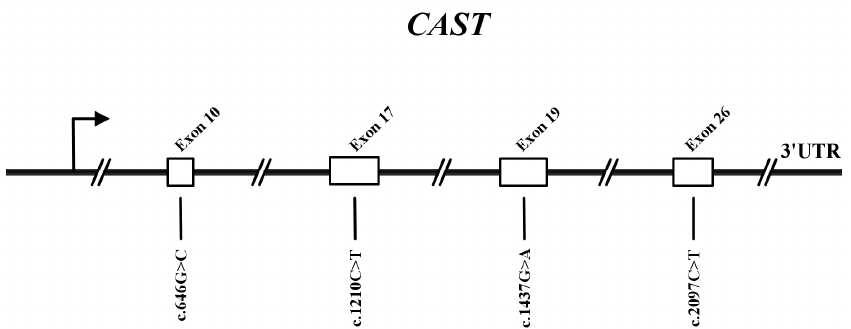
Figure 3. The physical locations of the four novel variants of the ovine CAST gene identified in this study are shown. The variant sites were according to chromosome 5 in Oar_rambouillet_v2.0 (Gen- Bank accession: NM_001009788.1).